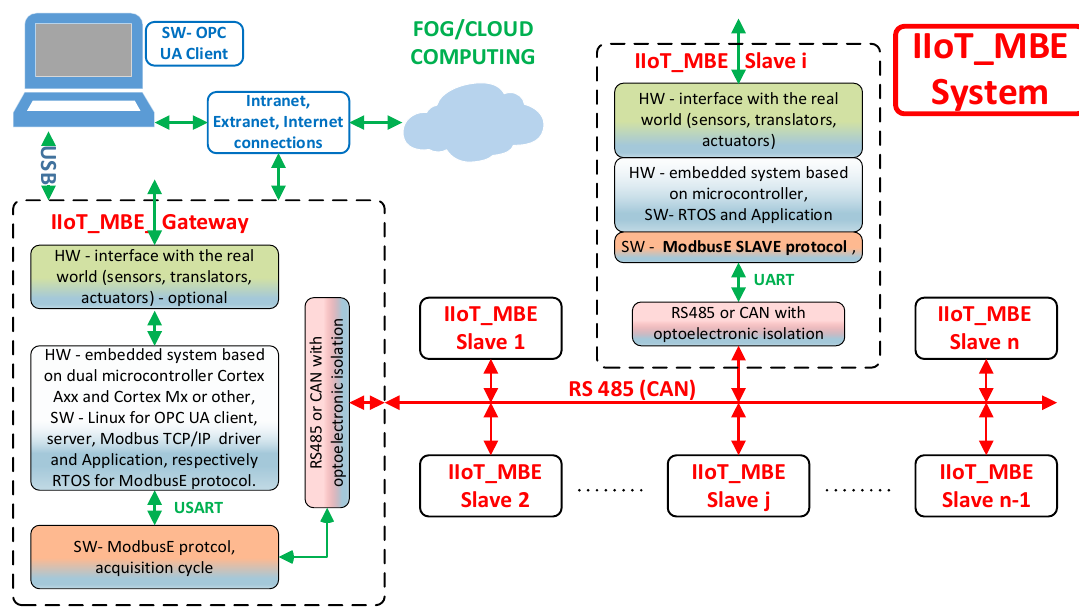
Figure 10. The main architecture of the experimental system for IIoT—ModbusE, (RTU) smart gateway. Another solution may be to use SoCs at the BSG level with Cortex-Ax, DSP, or